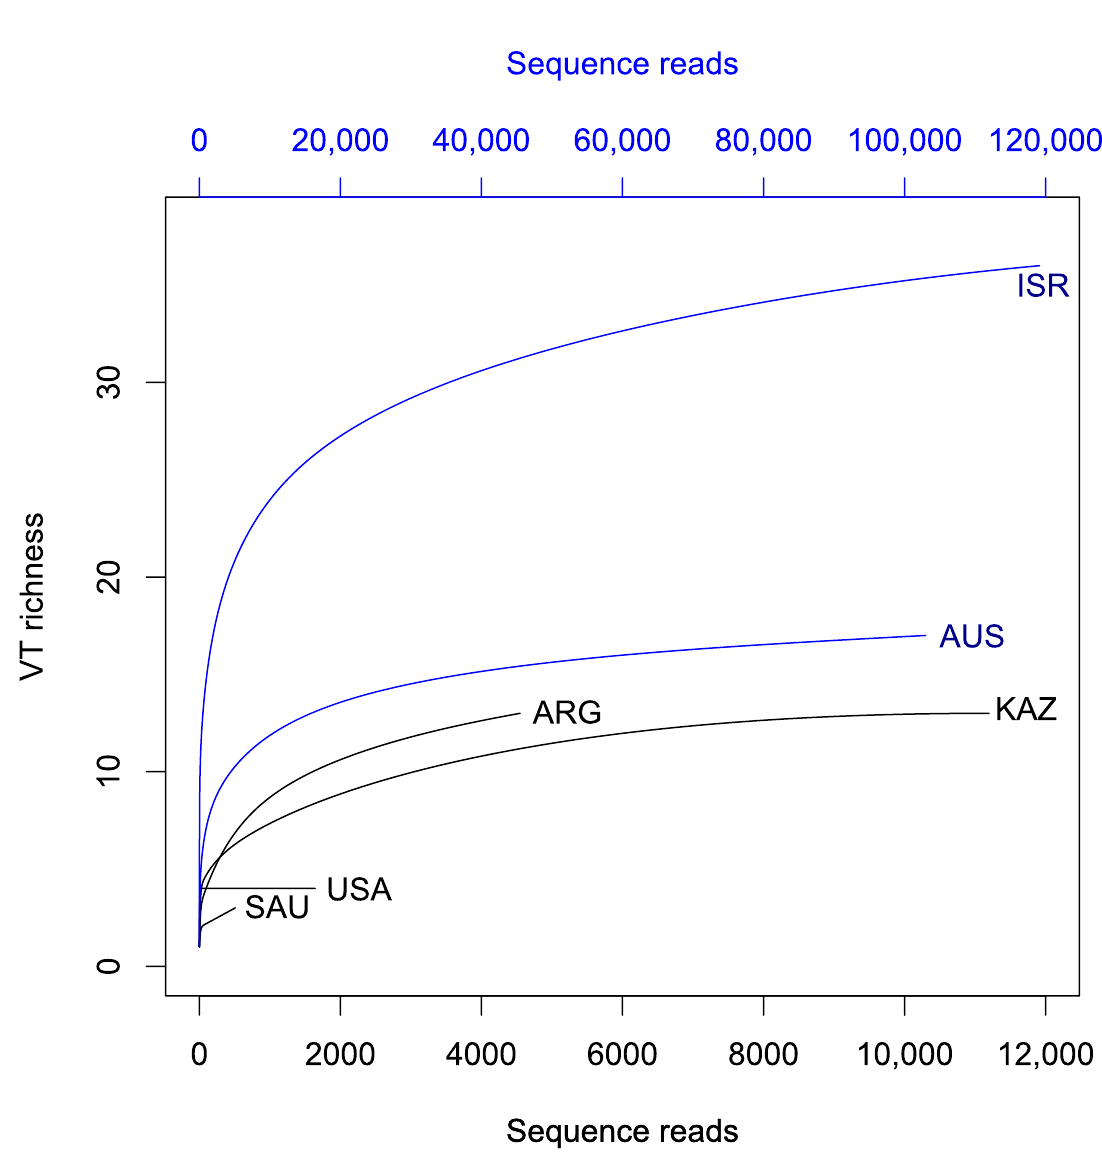
Figure 2. Rarefaction curves for study sites—accumulation of AM fungal VT in relation to the number of reads. Blue lines use scaling of axis on the top. Part of the samples AUS and ISR curves are cut-off to fit the